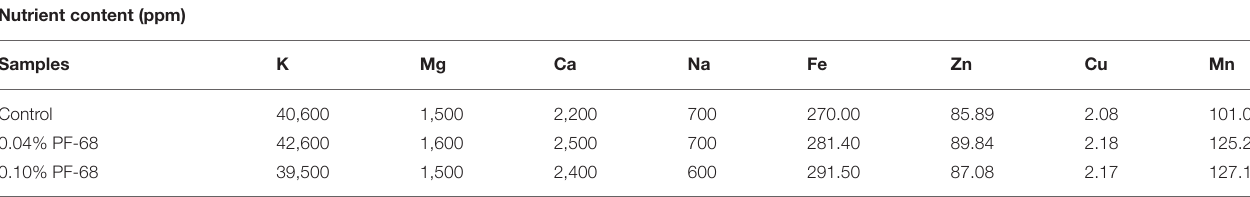
TABLE 1 | The concentration of nutrient ions content in control callus, and calli supplemented with 0.04% PF-68 and 0.10% PF-68 after 4 weeks of incubation. Nutrient content